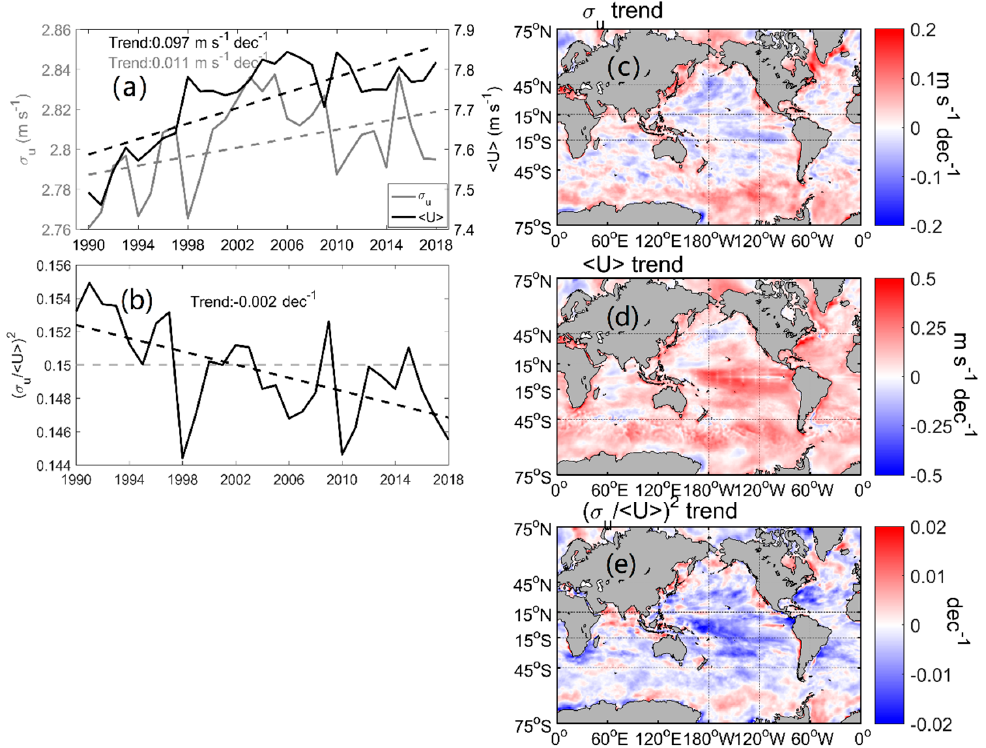
Figure 4. Left panel: time series of global ( a ) monthly averaged wind speed (cid:104) U (cid:105) (in black) and standard deviation ( σ u , in grey) around (cid:104) U (cid:105) , ( b ) monthly squared coefficient of variation I u2 = ( σ u / (cid:104) U (cid:105) ) 2 from 1990 to 2018 (note the small variations along the ordinate axis). The black and the grey dashed lines in ( b ) indicate the long-term trend (0.002 dec − 1 ) and average (I u2 = 0.15), respectively. Right panel: spatial distribution of ( c ) trends in the wind speed standard deviation ( σ u ) around (cid:104) U (cid:105) , ( d ) monthly averaged wind speed (cid:104) U (cid:105) , and ( e ) monthly squared coefficient of variation I u2 = ( σ u / (cid:104) U (cid:105) ) 2 from 1990 to 2018.